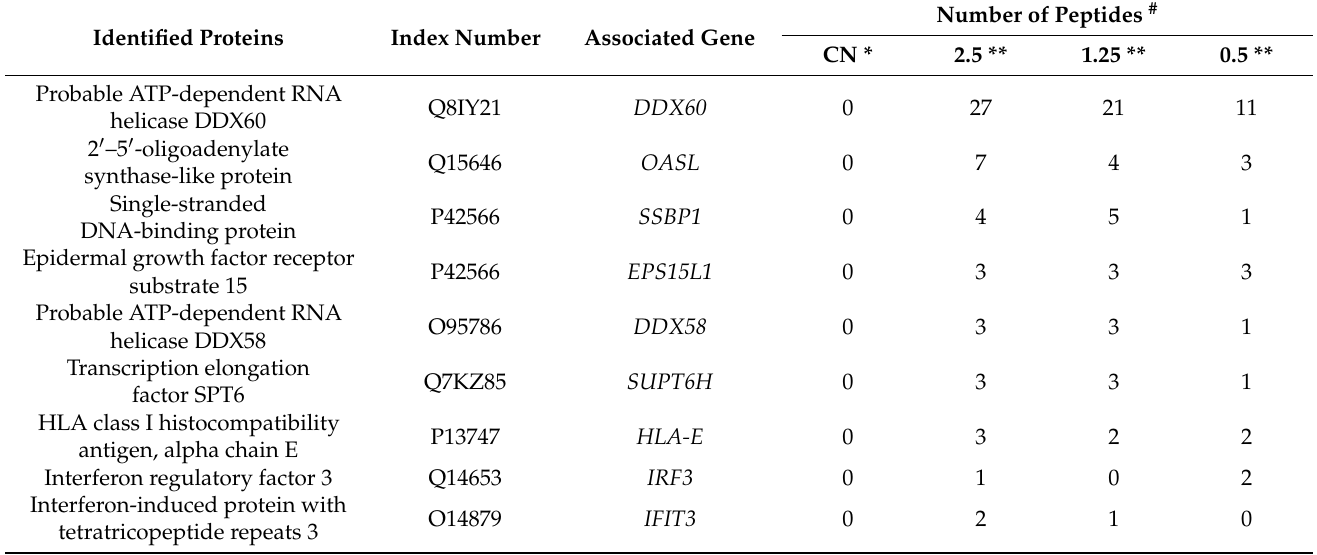
Table 1. Upregulated antiviral proteins in BxPC-3 cells that were treated with Rintatolimod. Identified